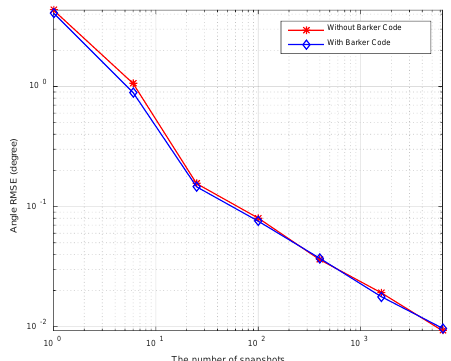
Figure 15. RMSEs versus the number of snapshots.